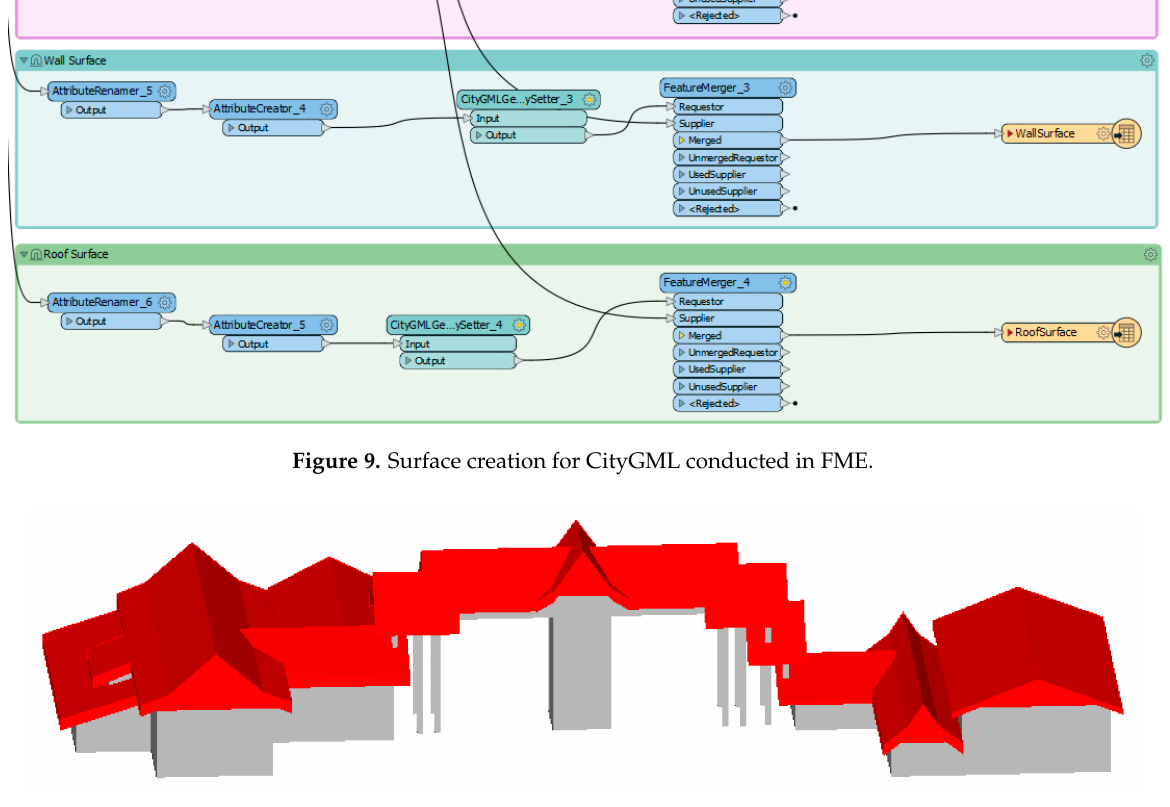
Figure 11. List of non-spatial attributes stored in a database.